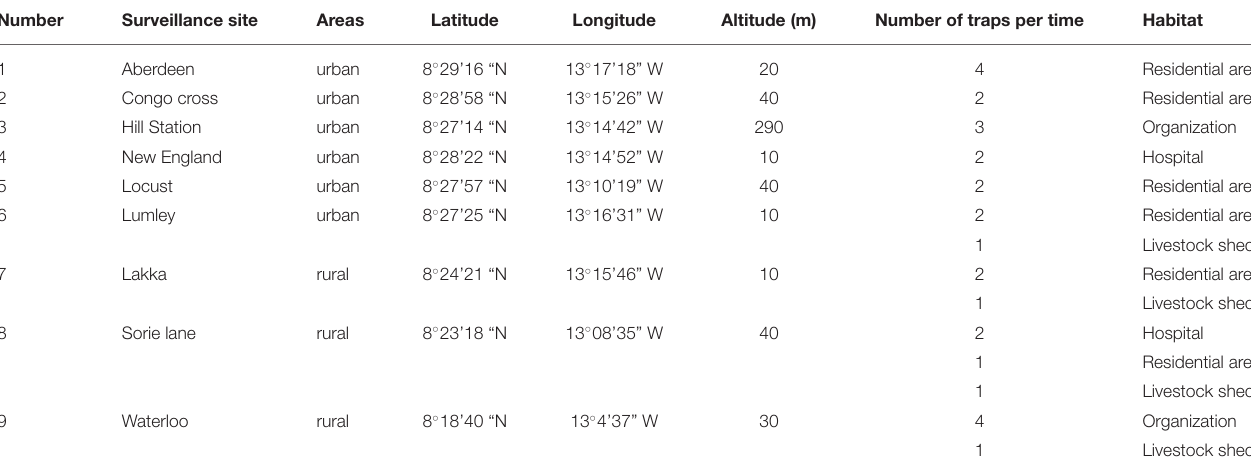
TABLE 1 | Information of mosquito surveillance